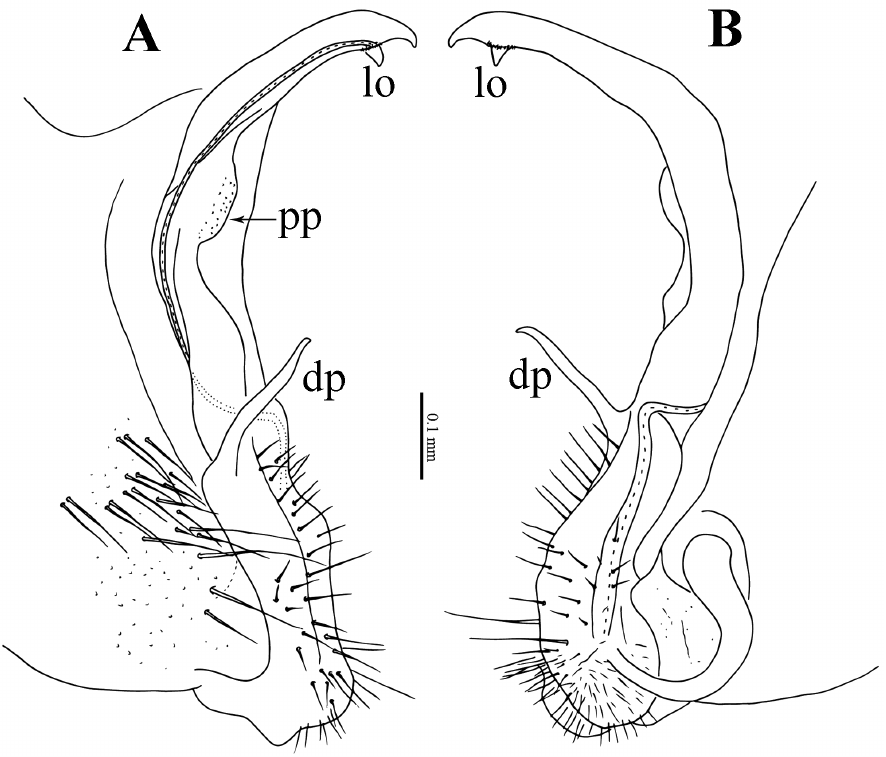
Figure 4. E. steineri sp. n., male paratype from Cave Tham Deu. A–B right gonopod, sublateral and mesal views, respectively. Abbreviations: dp = distofemoral process; pp = papillate process; lo =